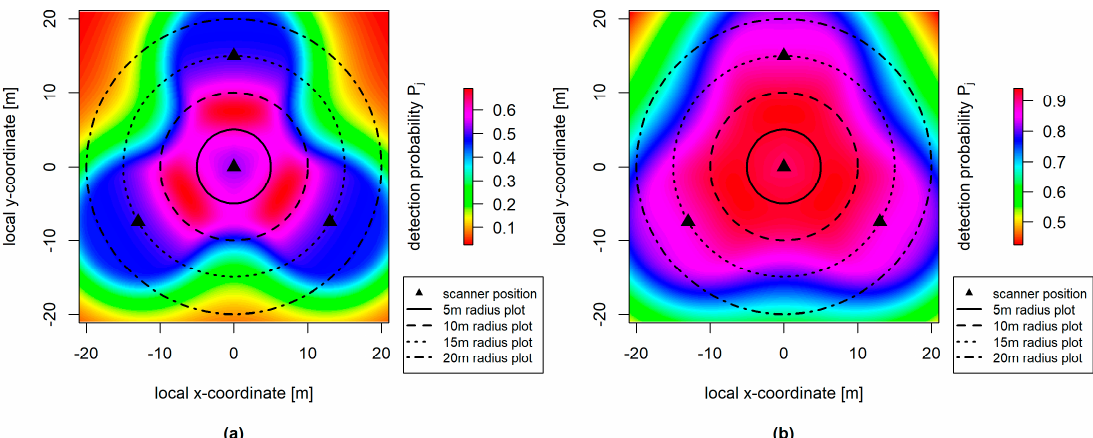
Figure 6. Distance-dependent detection probabilities P j for multi-scan TLS for both strata. Cell size of the raster is 1 cm × 1 cm. ( a ) Small trees (5 cm ≤ dbh < 20 cm) and ( b ) large trees (dbh ≥ 20 cm).